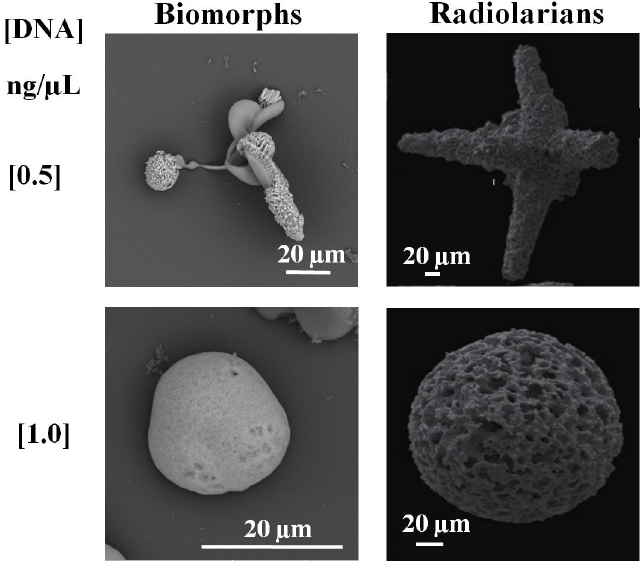
Figure 3. Representative microphotographs of biomorphs synthetized at 1.0 and 0.5 ng/µL of DNA with 5% CO 2 in comparison with a radiolarian of sponge spicules from the Niujiaohe Formation in Chongyi County, Jiangxi Province (with permission from Zhang and Feng, 2019 [43]).